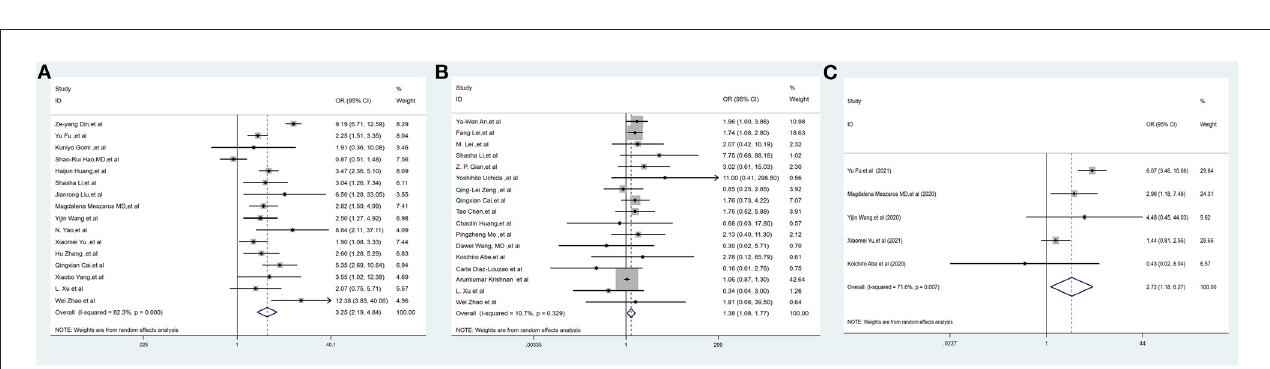
FIGURE2 Forest plots of the included studies evaluating abnormal liver chemistries between severe and non-severe patients with COVID-19. (A) Prevalence of liver injury. (B) The proportion of patients with a history of CLD. (C) The mortality association of COVID-19 infection between liver injury and non-liver injury cases. CLD, chronic liver